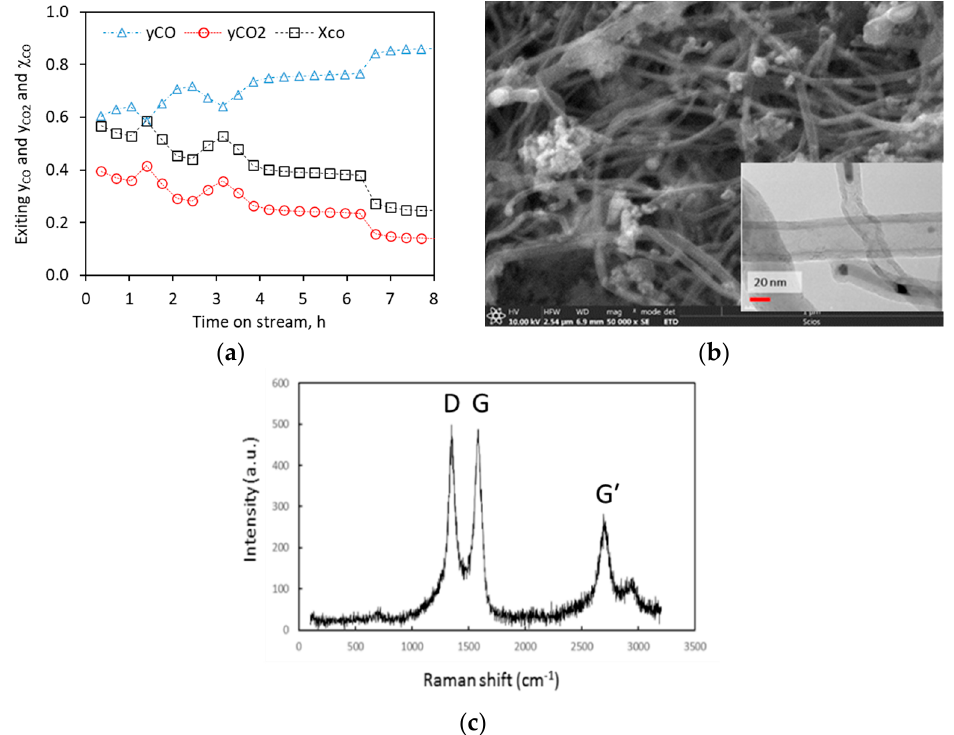
Figure 4. Results of MWCNT growth by CO reaction on the FeCr catalyst at 500 °C and 5.1 bar: ( a ) CO conversion and gas product composition as a function of reaction time, ( b ) SEM and TEM (insert) images of the MWCNTs, and ( c ) Raman shift spectrum of the produced MWCNTs.